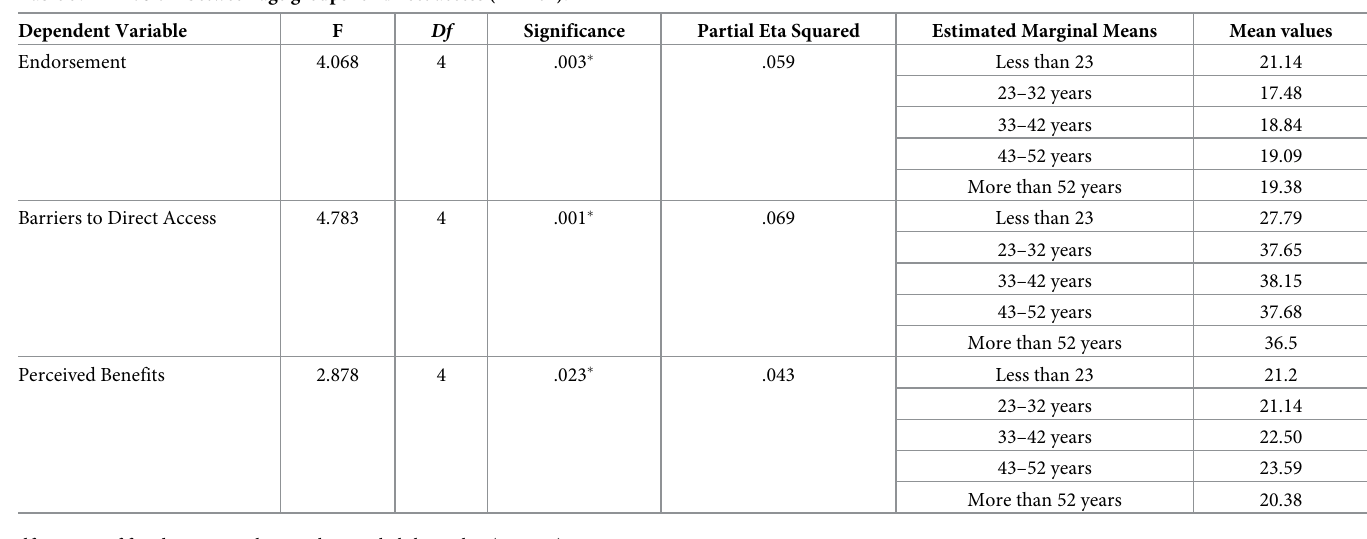
Table 3. MANOVA between age groups for direct access (n =